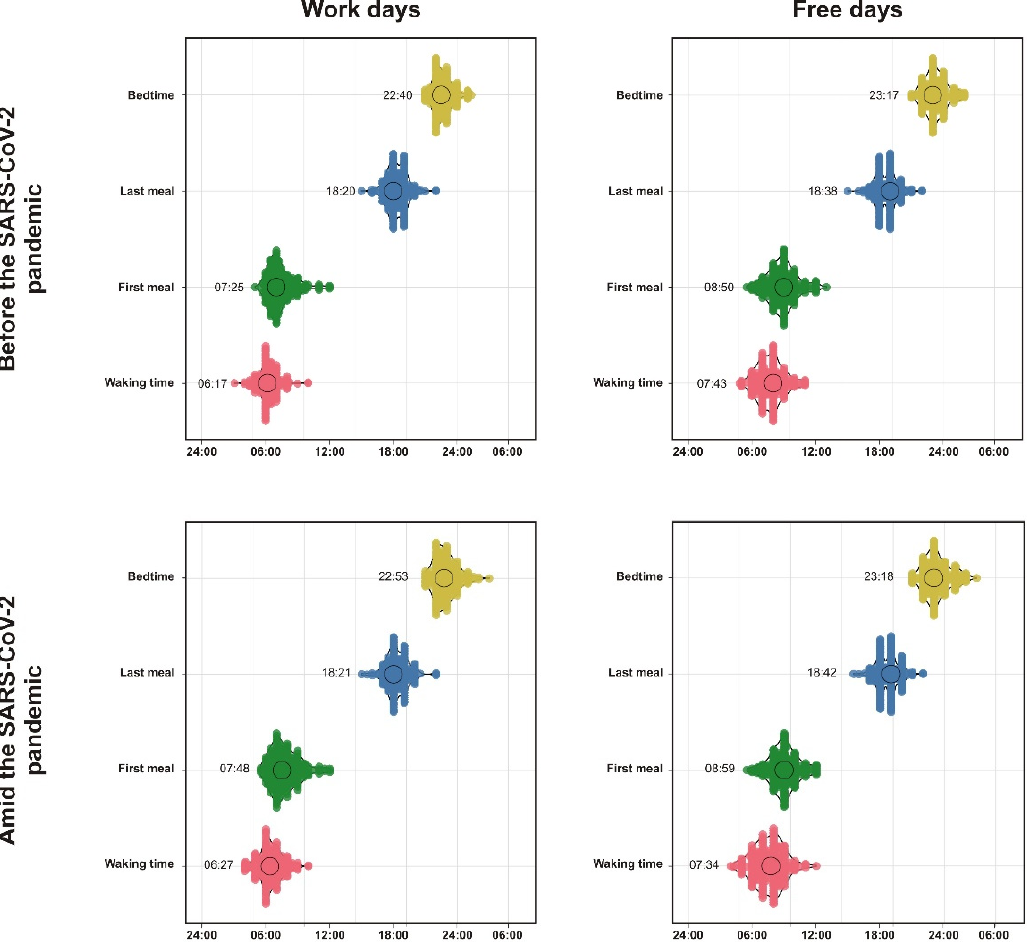
Figure 1. Meal and sleep timing variables before and amid the COVID-19 pandemic, split by work and free days. Mean value (in military time) is shown next to each figure element; y-axis shows frequency over clock time.